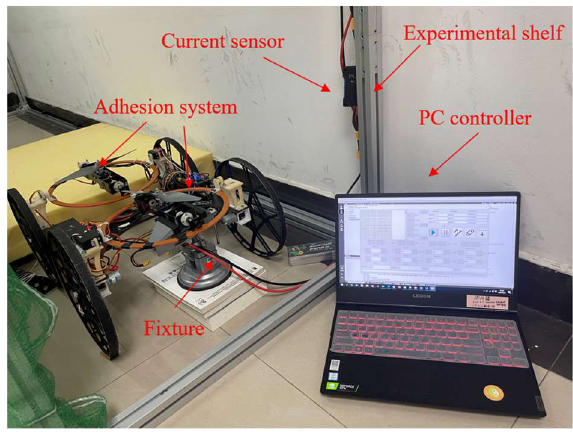
Figure 9. Aerodynamic characteristics measurement platform.